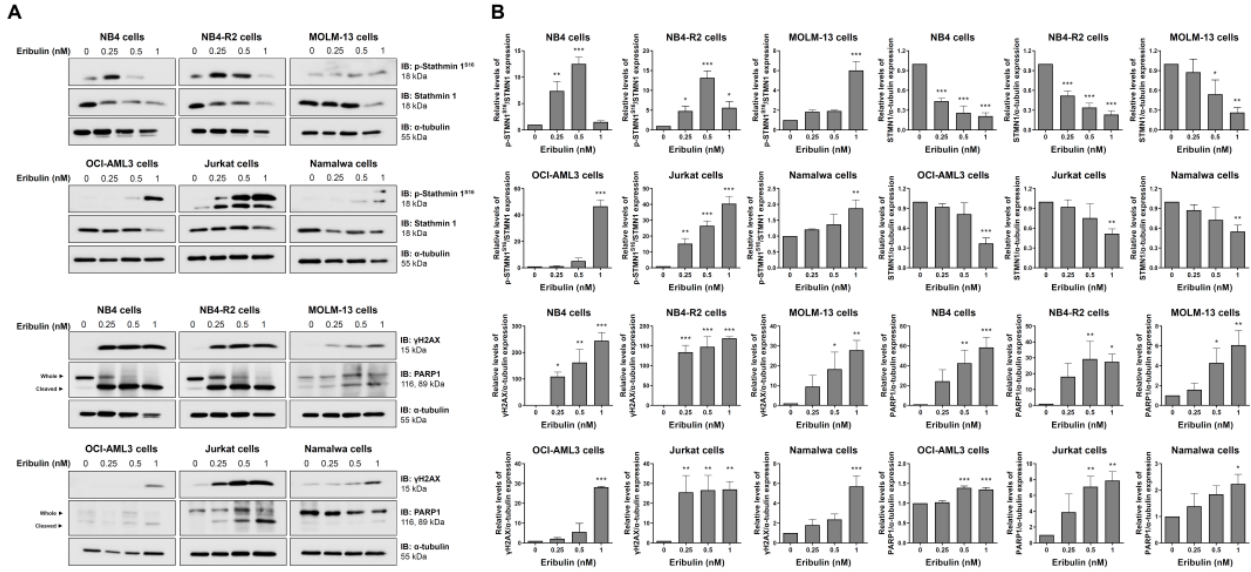
Figure 6. Eribulin induces molecular markers of DNA damage and apoptosis in acute leukemia cells. ( A ) Western blot analysis for levels of phospho(p)-STMN1 S16 , STMN1, γH2AX, and PARP1 (total and cleaved) in total cell extracts of vehicle- and eribulin-treated acute leukemia cells (0.25, 0.5, and 1 nM) for 48 h; Membranes were incubated with the indicated antibodies and developed